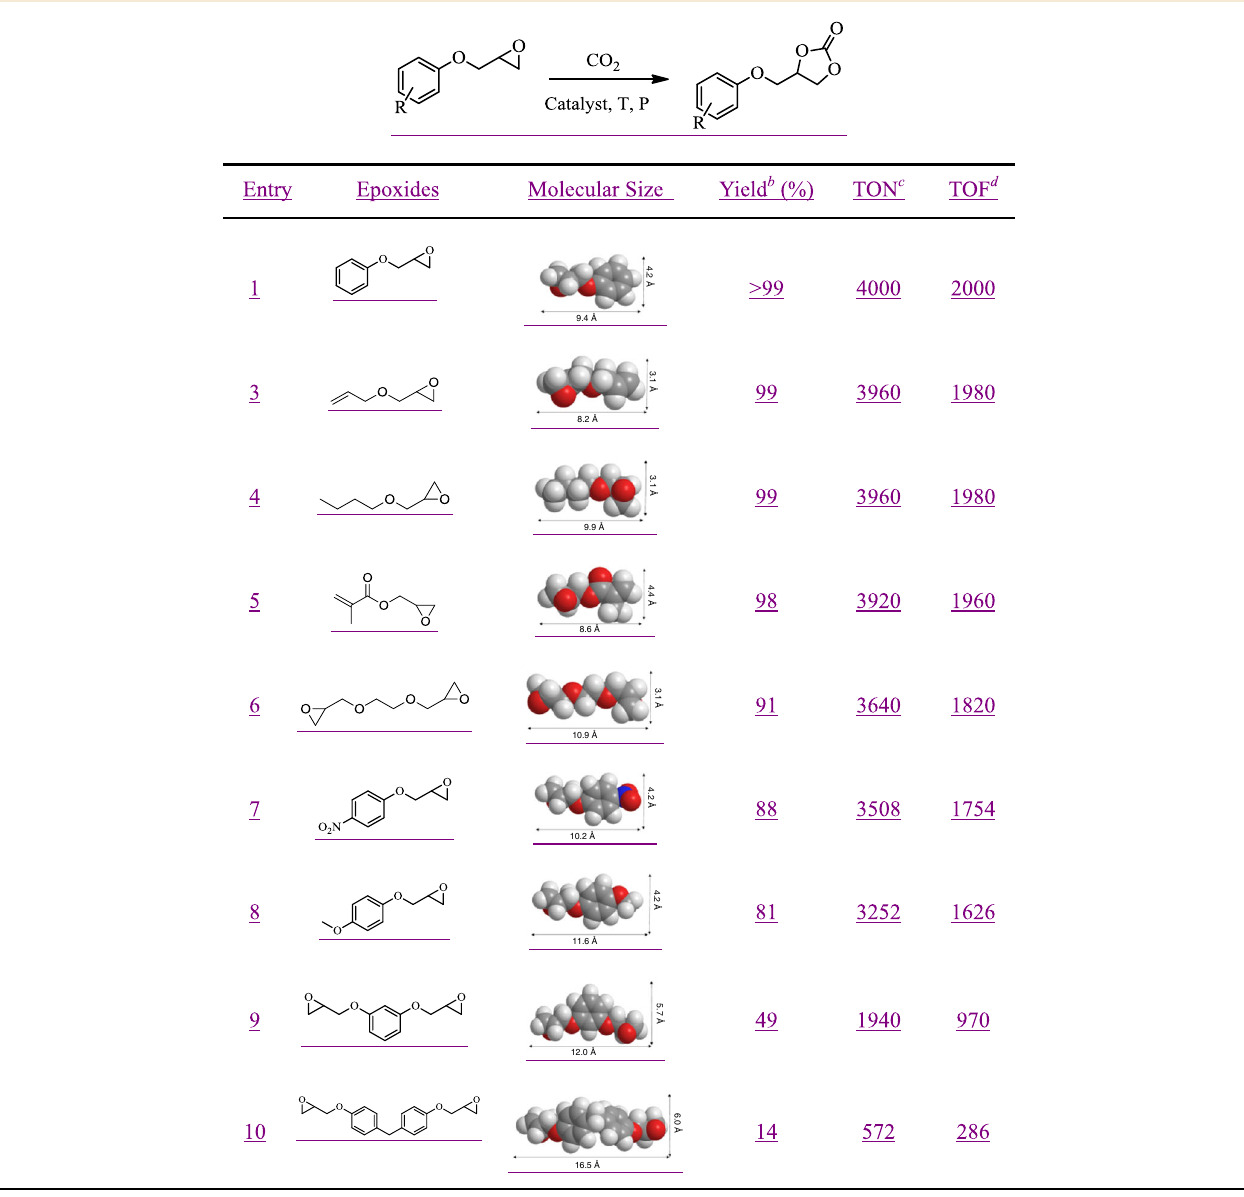
Table 1 Zn-DPA-catalyzed coupling of epoxides with CO 2